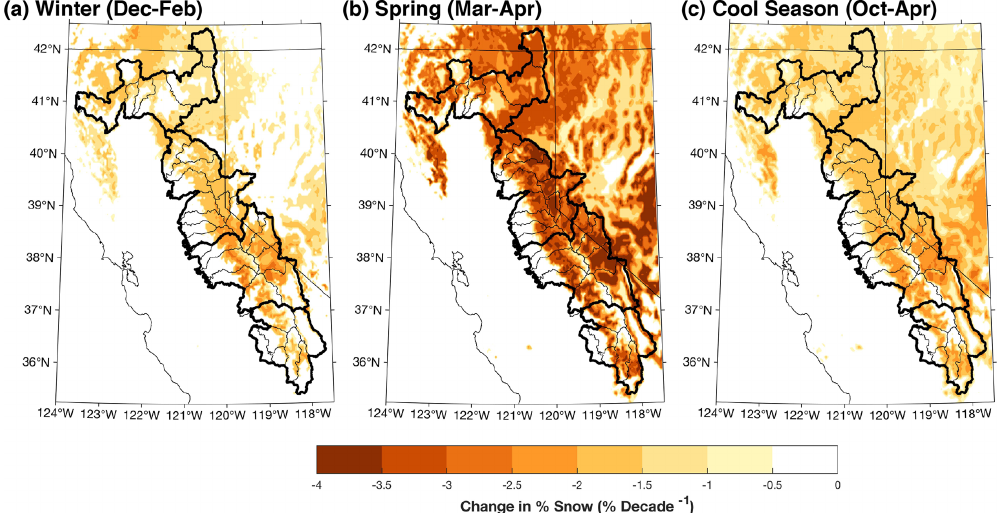
Figure 3. Estimated changes in % SNOW (in % per decade) for (a) winter (December–February), (b) spring (March–April), and (c) for the full cool season (October–April). Thick black contours denote California Department of Water Resources analysis zones. Thin black contours denote United States Geological Survey HUC 8 watersheds. Only grid points with statistically significant ( p < 0 . 05) trends are shown; Fig. S1 shows trends for all grid points.